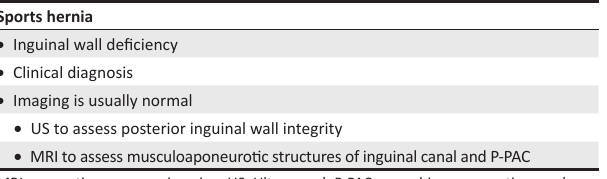
TABLE 1: Sports hernia – key